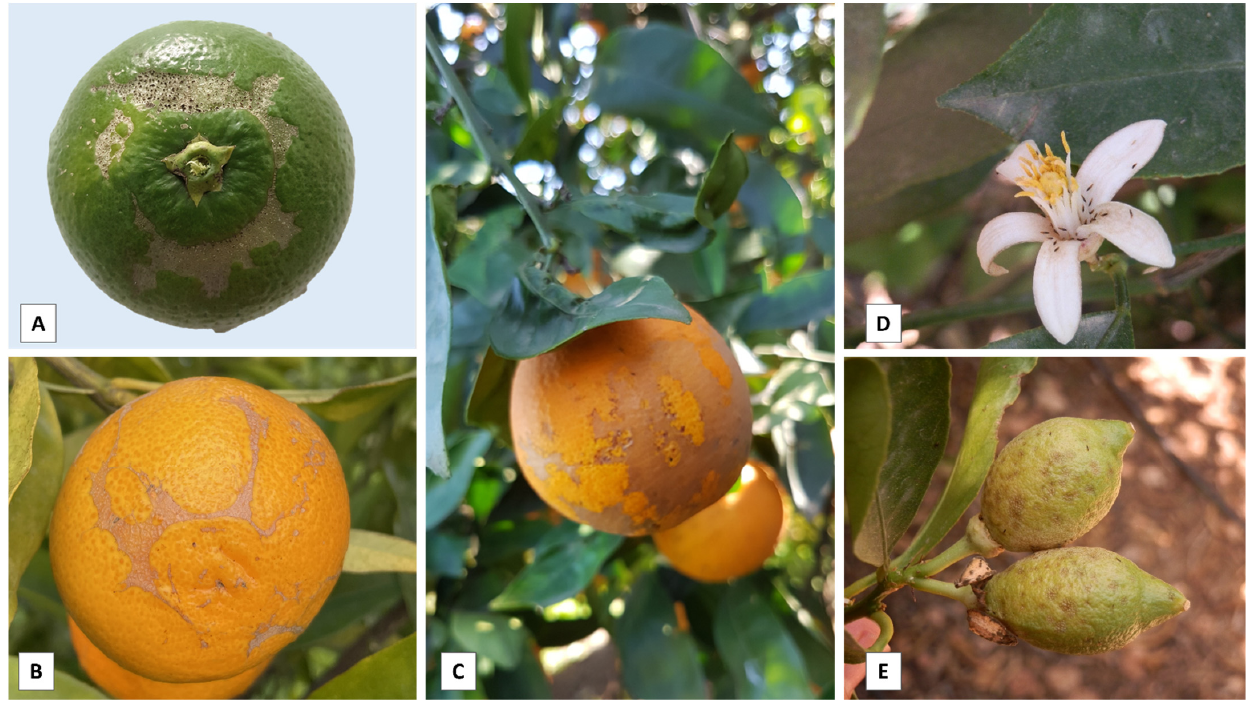
Figure 2. Kelly’s thrips damage symptoms on lemon ( A ), clementine ( B ), and orange ( C ) fruits; damage symptoms due to Thirps hawaiiensin on lemon flowers ( D ) * and fruits ( E ) * in Turkey (* courtesy of Prof. Ekrem Atakan).